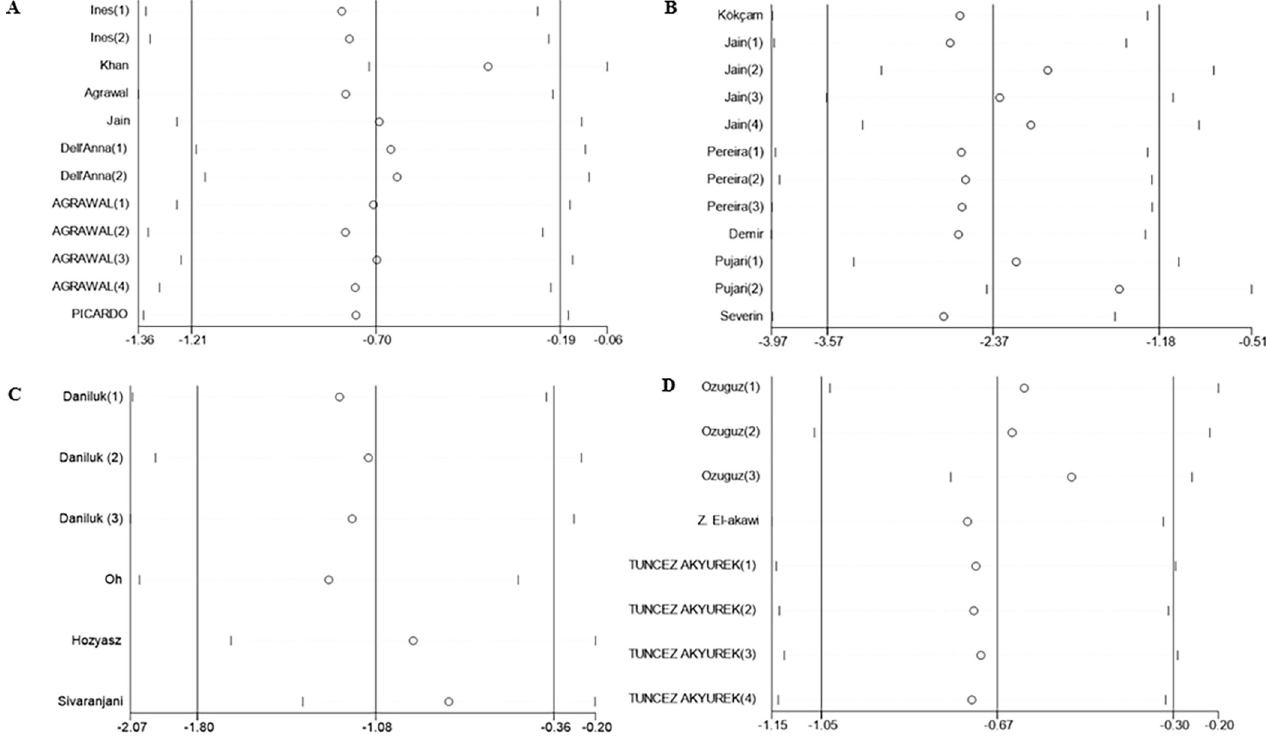
Fig 7. Sensitivity analysis of studies included in meta-analysis. A: Vitiligo; B: Psoriasis; C: Atopic dermatitis; D: Acne.